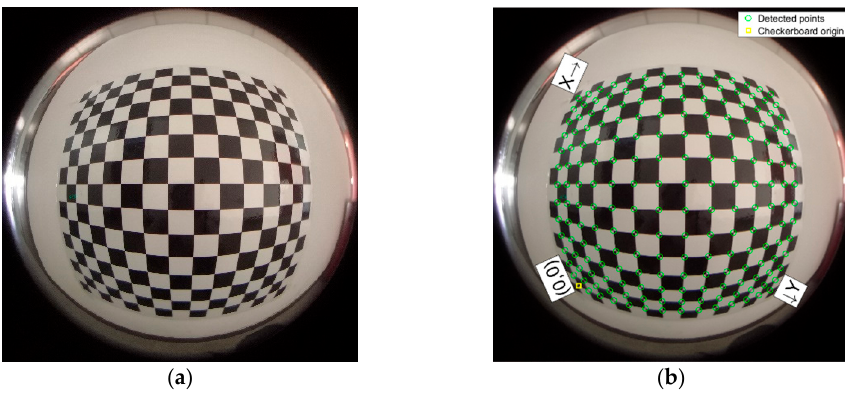
Figure 6. Checkerboard and corner extraction. ( a ) Fisheye image; ( b ) Corner extraction.